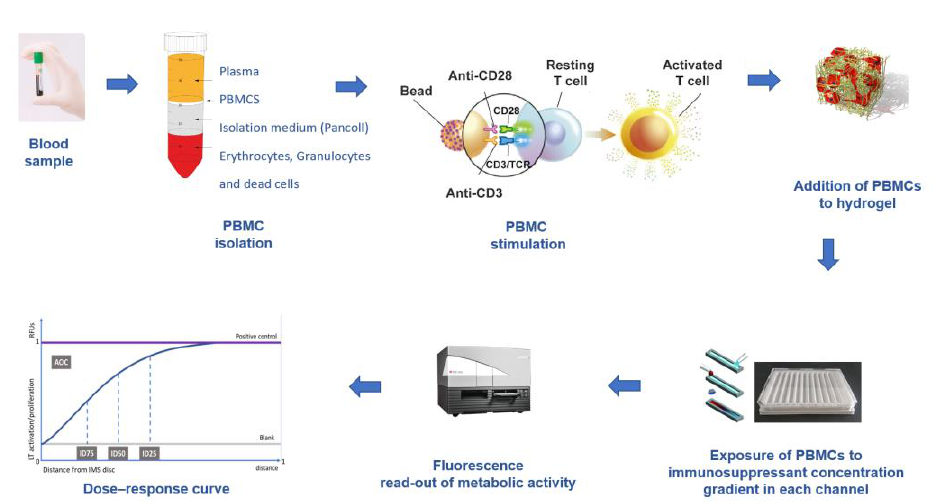
Figure 2. IMBG assay procedure. PBMCs are extracted from the patient’s blood sample and immunologically stimulated to induce their activation and proliferation. These activated PBMCs are embedded in a hydrogel substrate, which is then loaded into segregated channels in the IMBG plate. PBMCs in each channel are exposed to a concentration gradient of a distinct immunosuppressant. Next, PBMC activation and proliferation along the concentration gradient are measured using a resazurin-based immunofluorescence assay, which provides a read-out of PBMC response to each immunosuppressant. For each immunosuppressant, dose–response curves are generated based on 15 immunofluorescence readings taken at sequential points along the concentration gradient in the IMBG channel.